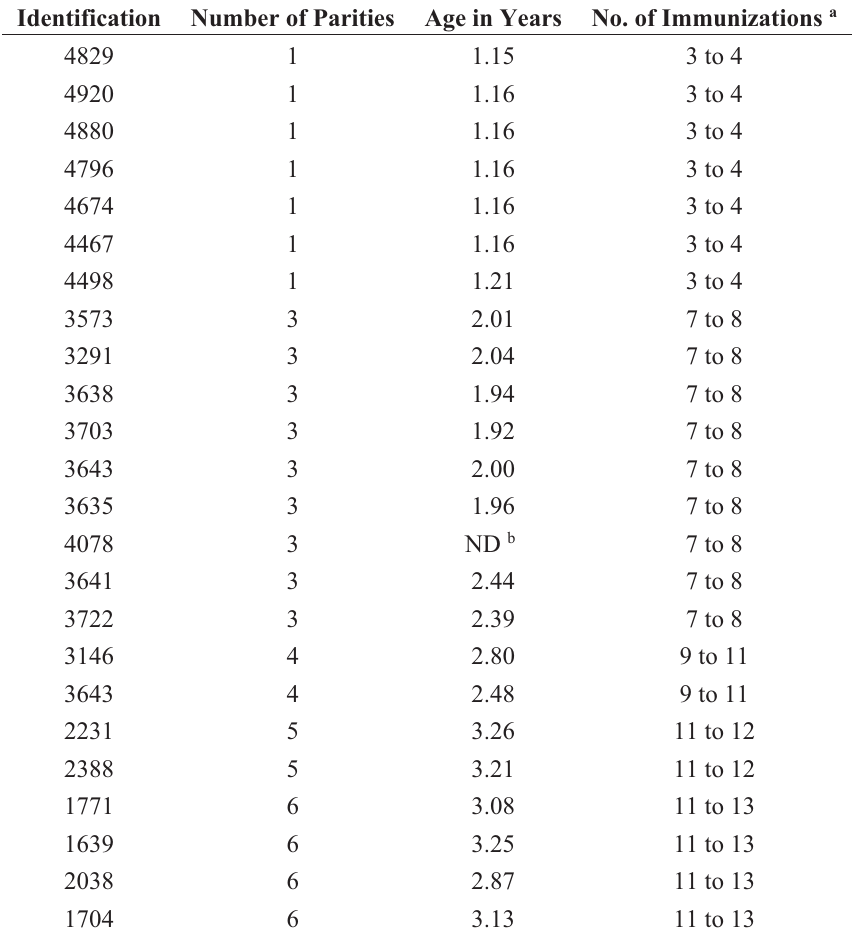
Table 1. Characteristics of sows included in this